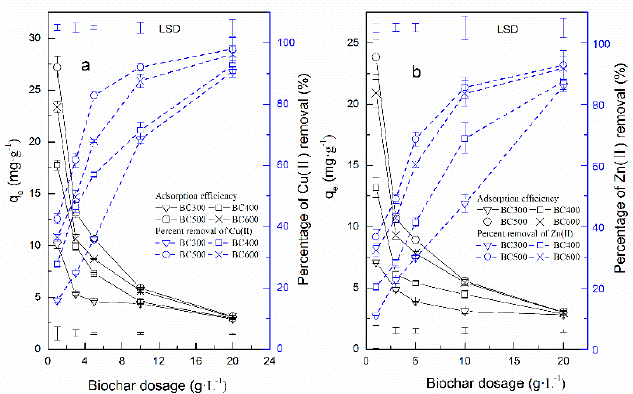
Figure 1. E ff ect of biochar (BC) dosage on the adsorption capacities and the removal e ffi ciency of the Figure 1. Effect of biochar (BC) dosage on the adsorption capacities and the removal efficiency of the Cu(II) ( a ) and Zn(II) ( b ) (initial Cu(II) concentration 64 mg L − 1 , initial Zn(II) concentration 65 mg L − 1 ; Cu(II) ( a ) and Zn(II) ( b ) (initial Cu(II) concentration 64 mg L −1 , initial Zn(II) concentration 65 mg L −1 ; reaction temperature 25 ◦ C; initial solution pH 5.0; contact time 1440 min). Error bars represent standard reaction temperature 25 °C; initial solution pH 5.0; contact time 1440 min). Error bars represent error ( n = 3). LSD is the least significant di ff erence at p < 0.05 under the same dose of standard error ( n = 3). LSD is the least significant difference at p < 0.05 under the same dose of BC.